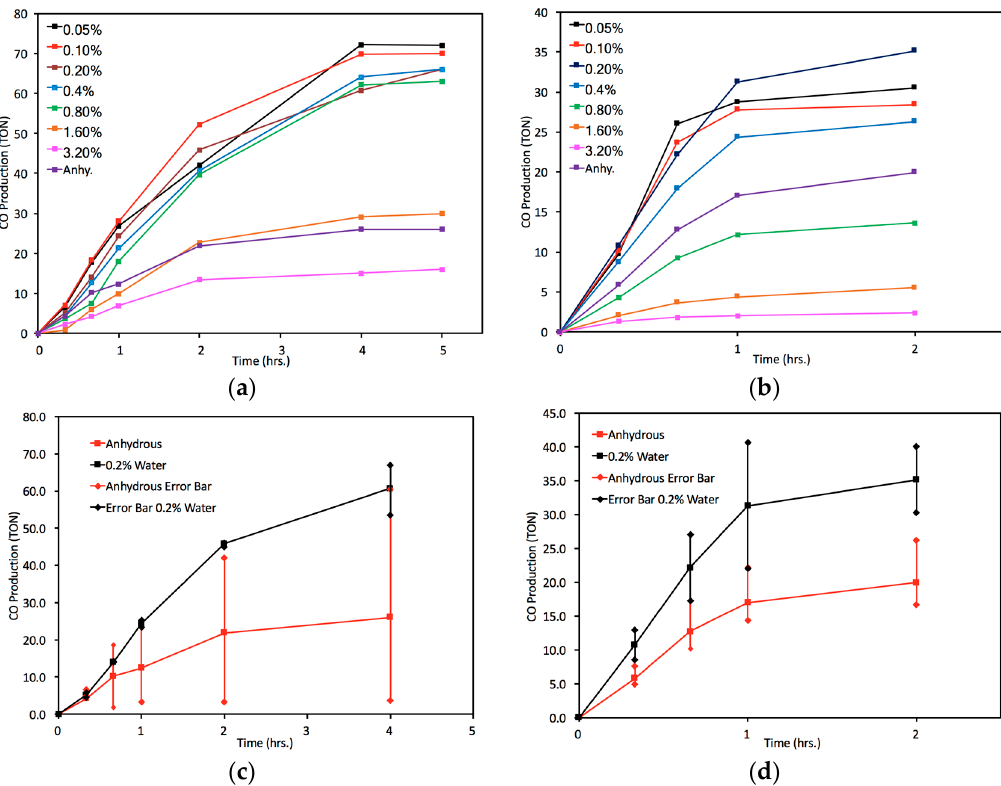
Figure 5. Turnover number (TON) values over time with varying water concentrations for ( a ) Re(bpy)(CO) 3 Cl and ( b ) Re(pyNHC-PhCF 3 )(CO) 3 Cl. Variation in TON values over time under anhydrous or 0.2% water volume with high and low TON values shown as vertical bars for ( c ) Re(bpy)(CO) 3 Cl and ( d ) Re(pyNHC-PhCF 3 )(CO) 3